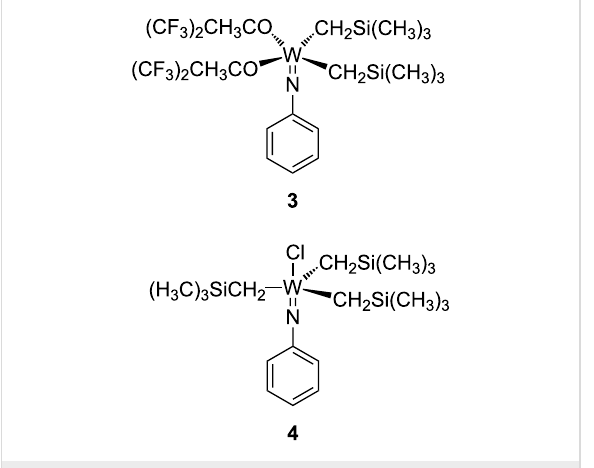
Figure 1: Well-defined tungsten photoactive catalysts.